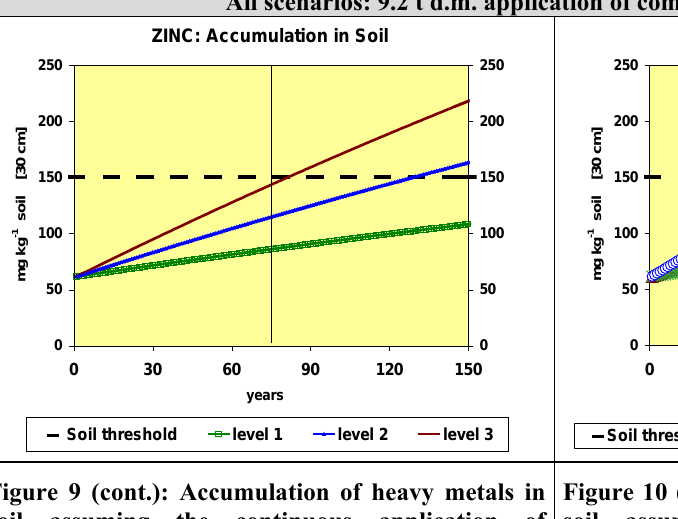
Figure 9 (cont.): Accumulation of heavy metals in soil assuming the continuous application of composts with metal concentrations at 3 limit scenarios